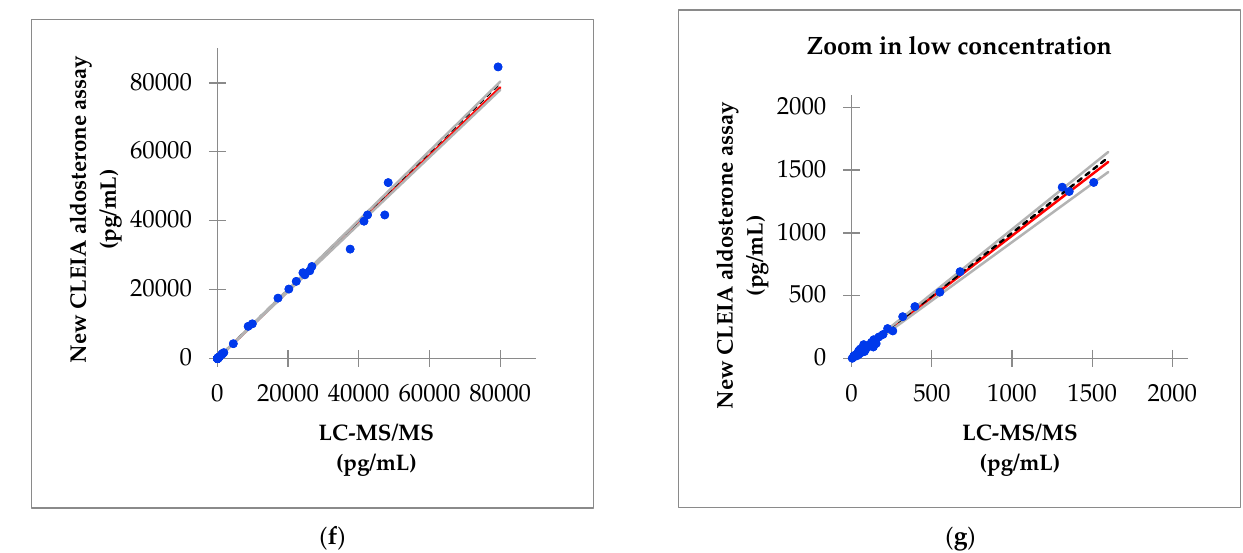
Figure 2. Results of the Passing − Bablok regression. ( a ) Serum versus plasma aldosterone concentrations measured using the improved reagent; ( b ) aldosterone concentrations measured using the improved reagent (new chemiluminescent enzyme immunoassay (CLEIA) aldosterone assay) versus the radioimmunoassay (RIA); ( c ) aldosterone concentrations measured using the improved reagent versus the RIA in a concentration range of up to 1600 pg/mL; ( d ) aldosterone concentrations measured using the new CLEIA aldosterone assay versus the current CLEIA aldosterone assay; ( e ) aldosterone concentrations measured using the new versus current CLEIA aldosterone assay in a concentration range of up to 1600 pg/mL; ( f ) aldosterone concentrations measured using the new CLEIA assay versus LC-MS/MS; ( g ) aldosterone concentrations measured using the new CLEIA assay versus LC-MS/MS in a concentration range of up to 1600 pg/mL.